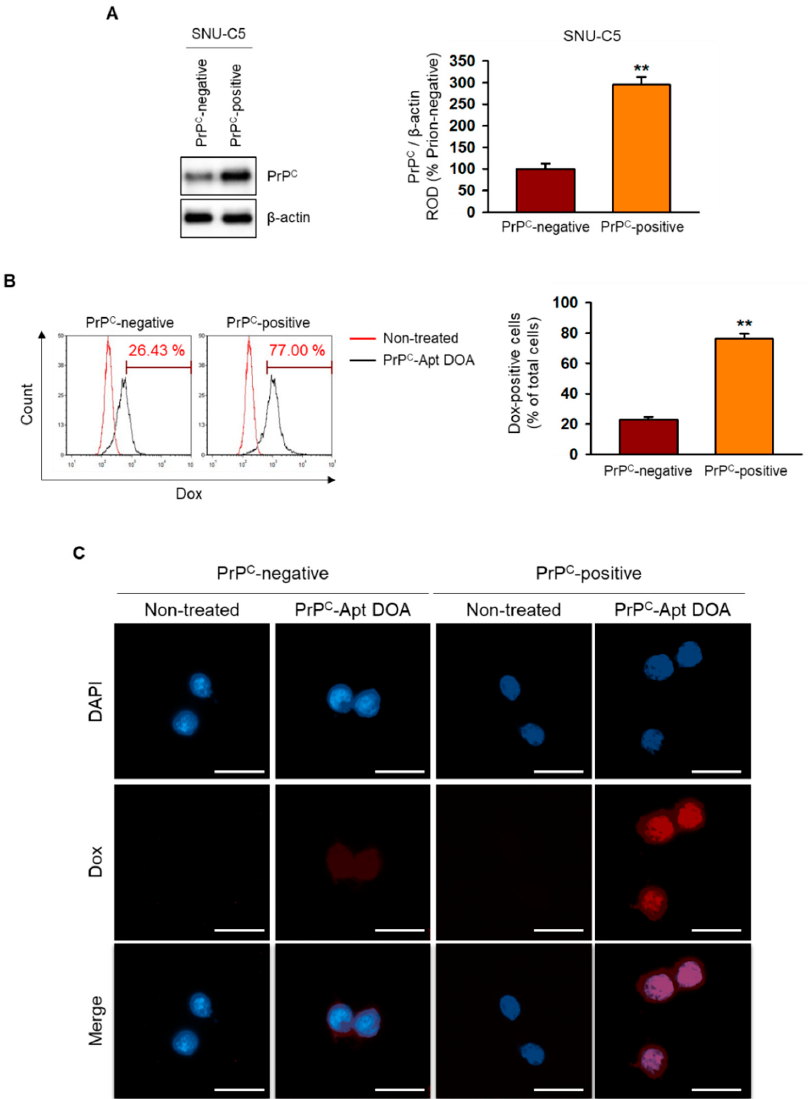
Figure 2. PrP C targeting of PrP C -Apt DOA. ( A ) Expression levels of PrP C were determined in PrP C - negative and PrP C -positive cells ( n = 3). ( B, C ) Cellular uptake of PrP C -Apt DOA in PrP C -negative and PrP C -positive cells were determined by using flow cytometry ( B ) and fluorescence microscopy ( C ) ( n = 3). Values represent mean ± SEM. ** p < 0.01 vs. PrP C -negative.